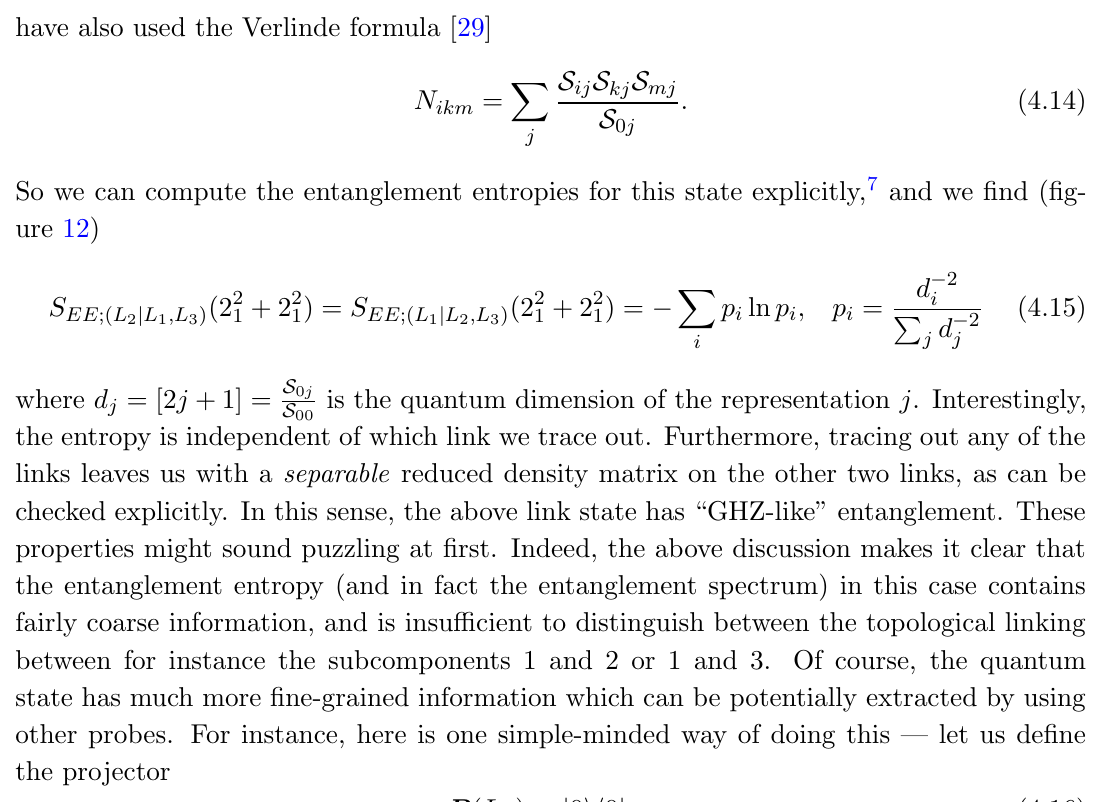
Figure 12 . The entanglement entropy S function of k